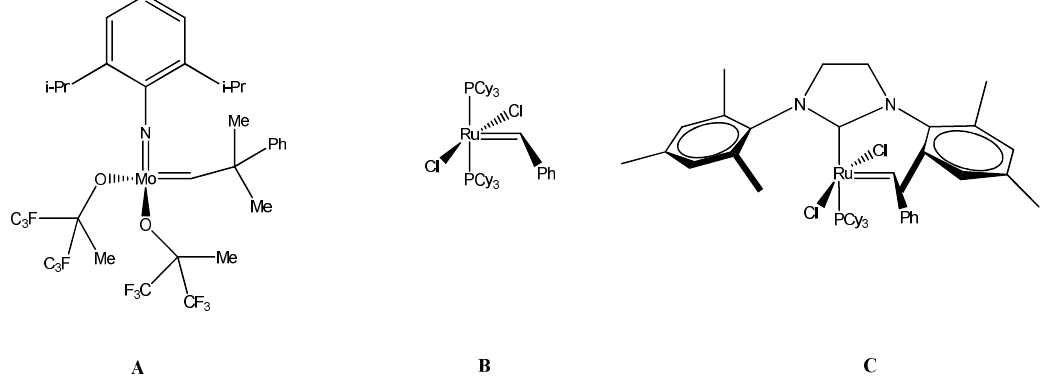
Figure 5. Metathesis catalysts, from the left: ( A ) Schrock’s molybdenum complex, ( B ) first-generation Grubbs catalyst, ( C ) second-generation catalyst.